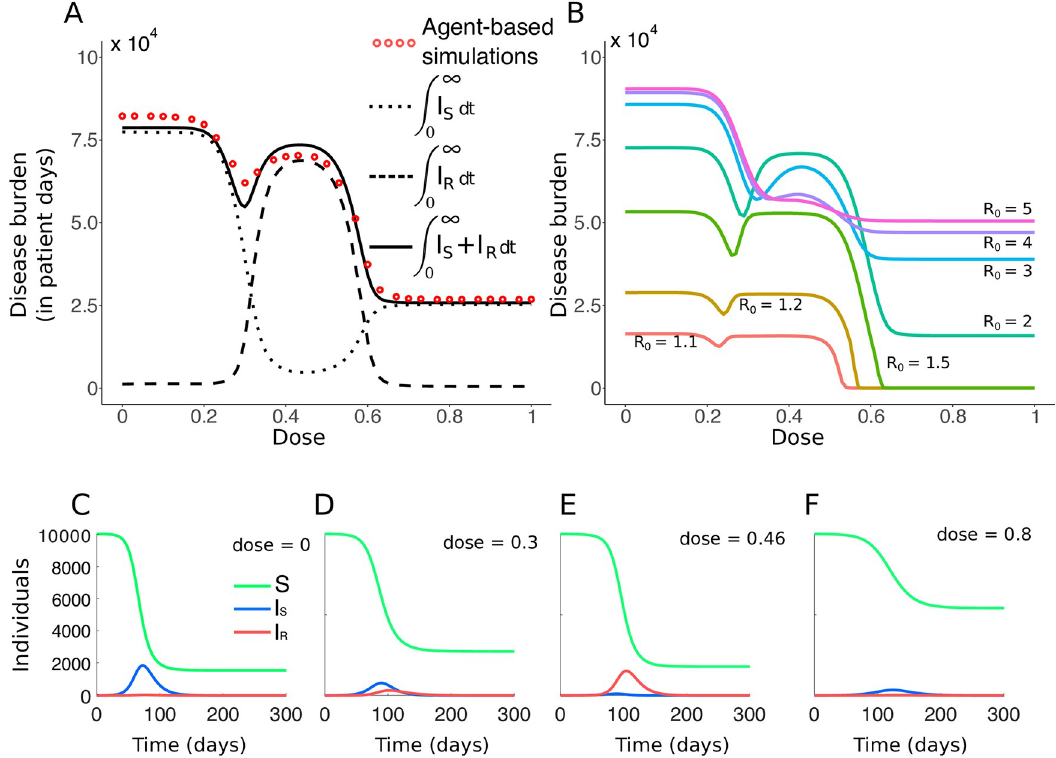
Fig 5. Effect of dose on the disease burden and infection dynamics. A: Comparison of the disease burden obtained with the nested model and the SIR model ( R 0 = 2.3). Each red dot represents the mean for 3800 to 4700 runs of simulation of the nested model, with β = 2.5 × 10 − 5 days − 1 . For the SIR model, the contributions of the sensitive and resistant strains to the disease burden are also shown. B: Burden curves (in patient days) for various values of R 0 . C-F: Exemplary population dynamics of the SIR model for four doses and R 0 = 2.3. Note that the burden B is the area-under-the-curve of the sum of the blue and red curves (number of individuals infected by each strain at time t ).